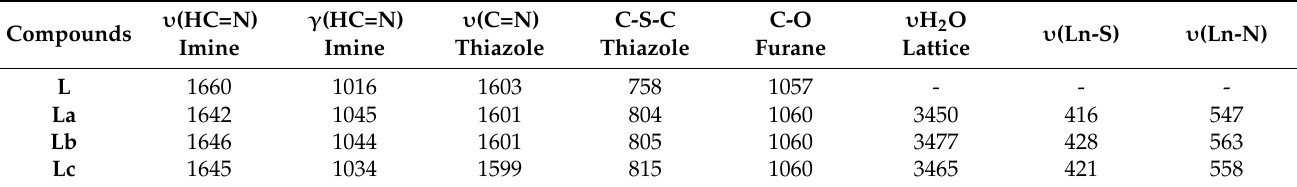
Table 1. Peak assignment in FTIR spectra (cm − 1 ) of L , La , Lb , and Lc